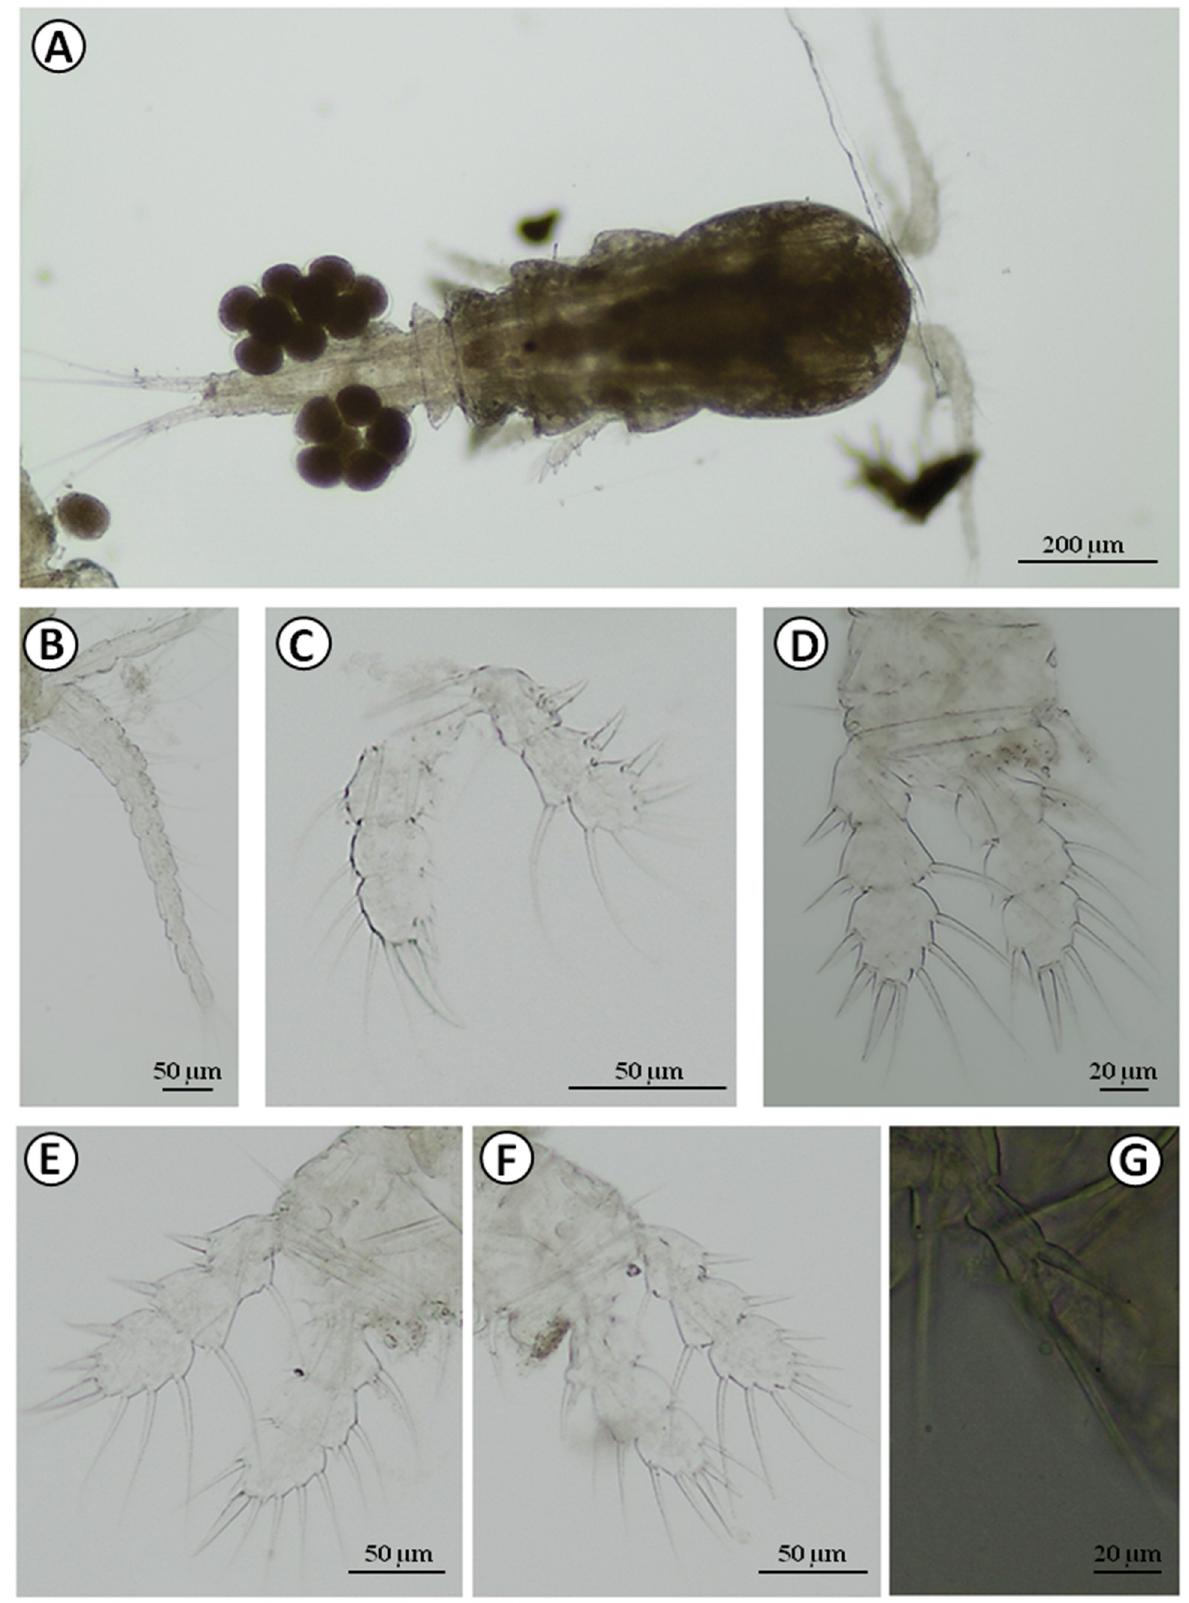
Figure 6. Diacyclops crassicaudis : A —body; B —antennule and antenna; C —P1; D —P2; E —P3; F —P4; G —P5.